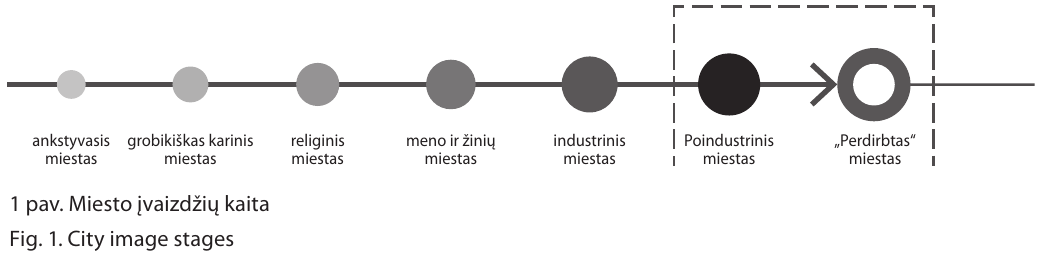
fig. 1. City image